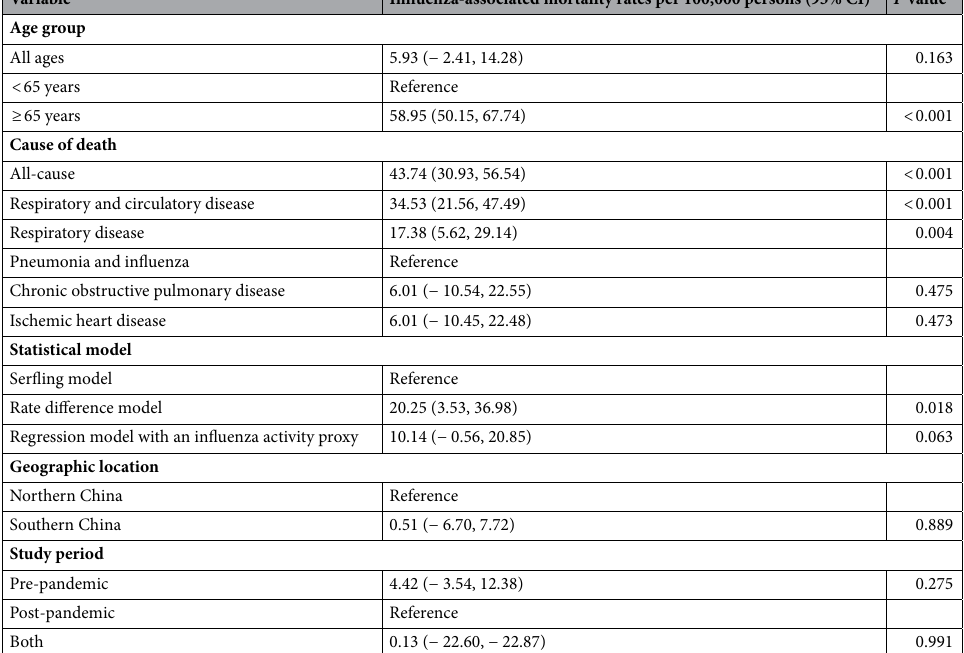
Table 2. Results of a meta-regression analysis conducted to identify factors that influence estimates of influenza-associated